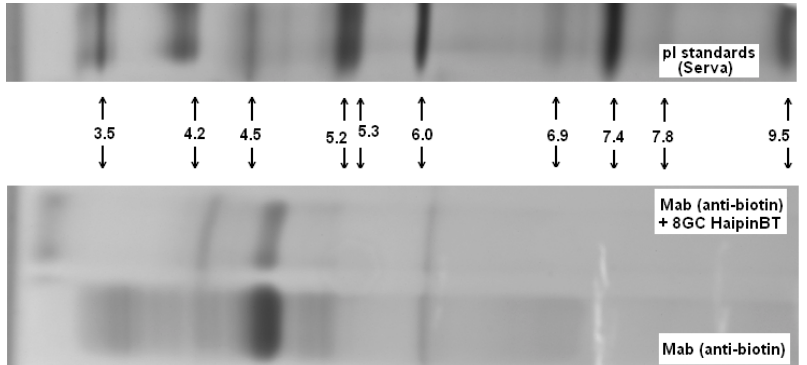
Figure 10. Biotinylated DNA hairpin (Bt-8gc) and mAb complex verification.